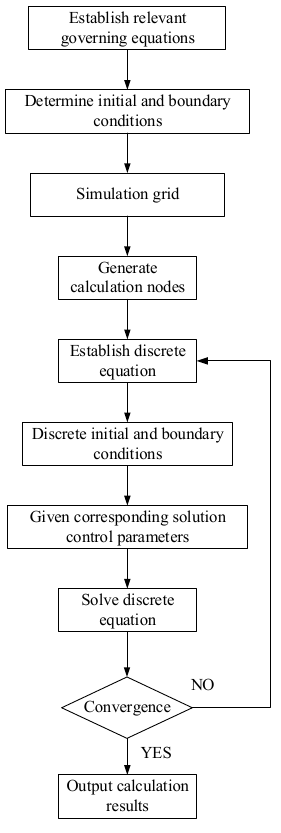
Figure 1. Calculation flowchart of AVL FIRE.